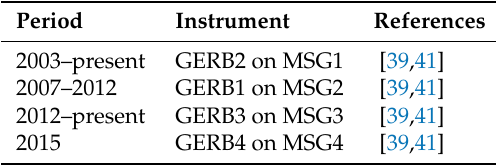
Table 5. Broadband Earth Radiation Budget space instruments on geostationary satellites. GERB: Geostationary Earth Radiation Budget; MSG: Meteosat Second